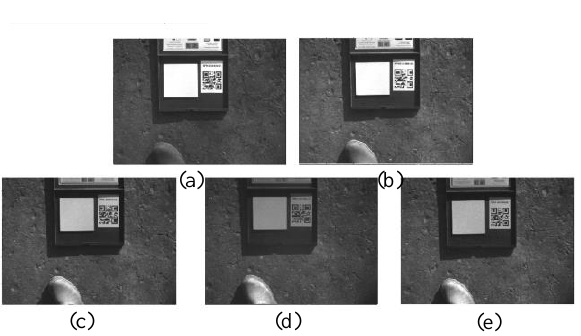
Figure 3. Data set 1: the image of a calibration panel in five bands with almost flat contents: (a) red, (b) green, (c) blue, (d) NIR, (e) red-edge.